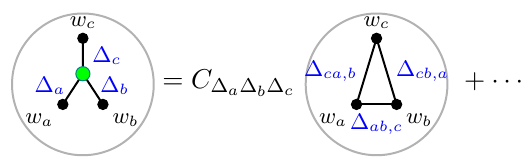
Figure 4. A schematic representation of a three-propagator identity. The common point of intersection of three bulk-to-bulk propagators, shown as a green disk on the LHS is to be integrated over all of AdS. The overall factor of C (cid:1) is the OPE coe(cid:14)cient associated with primaries a (cid:1) b (cid:1) c of conformal dimensions (cid:1) a ; (cid:1) b and (cid:1) c . We have only shown one of a four-fold in(cid:12)nity of terms which appear on the RHS. The precise identity can be found in (3.16). See section 3.2 for variants of this identity involving factors of the bulk-to-boundary